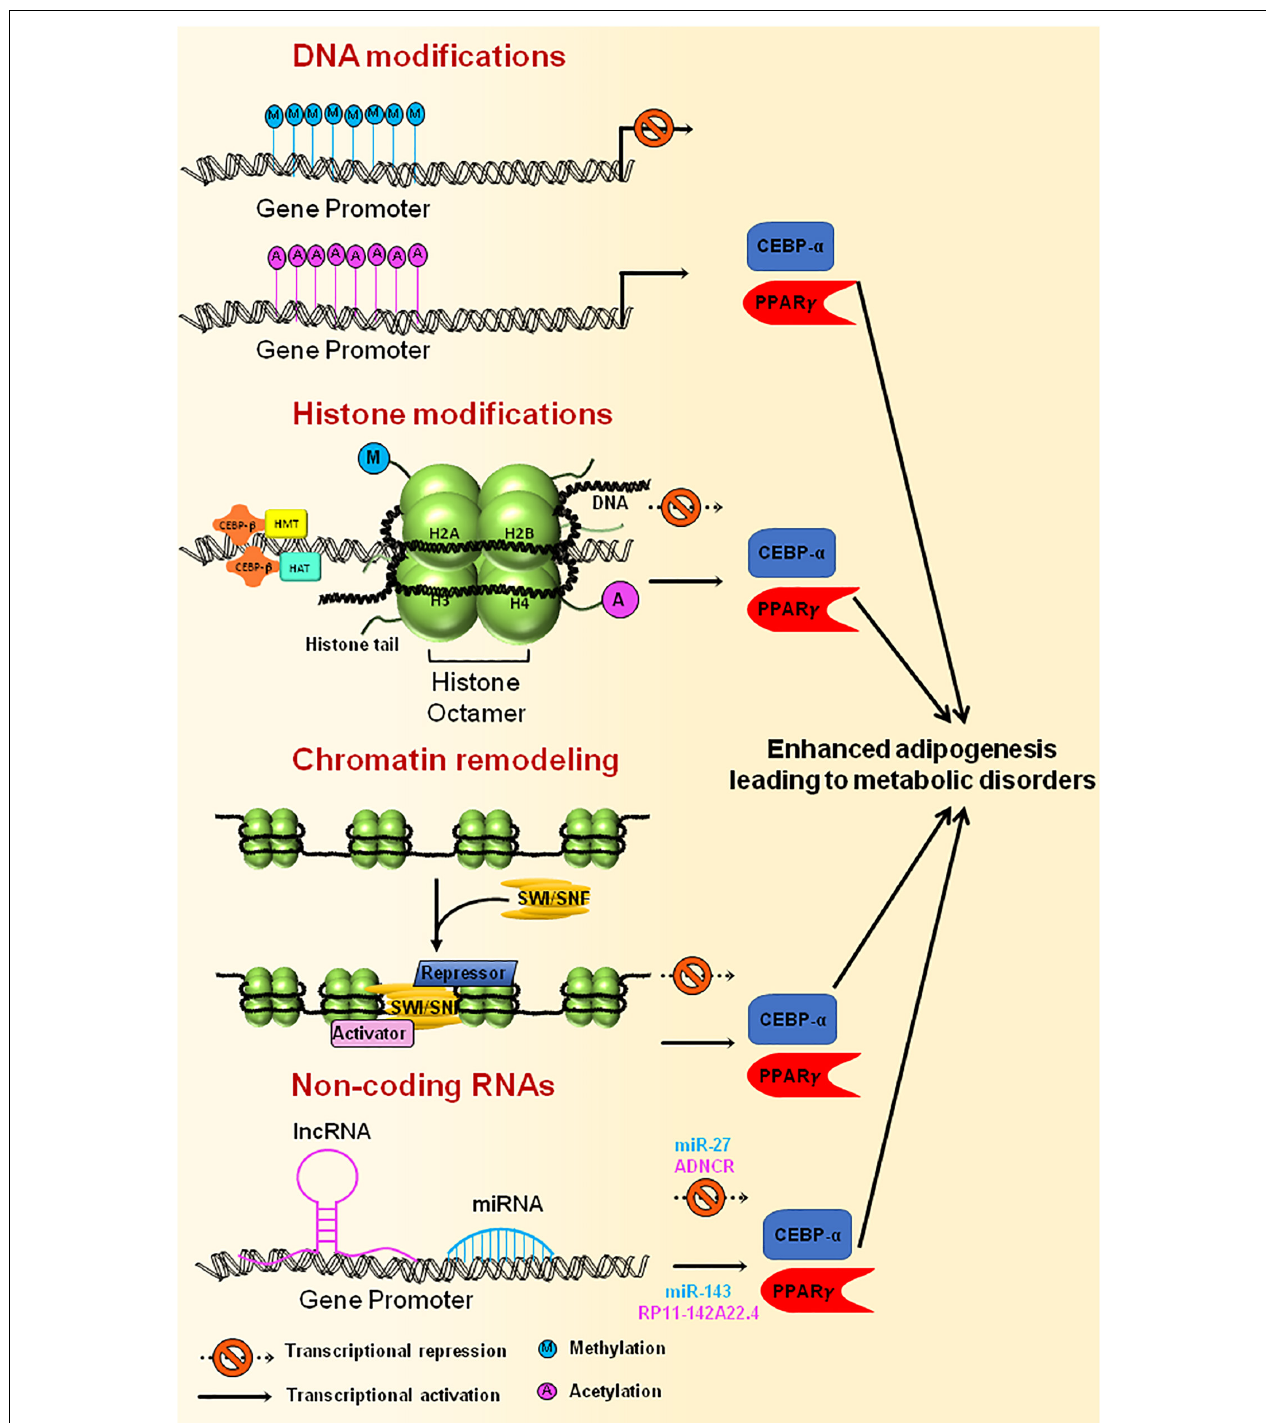
FIGURE 5 | Epigenetic modification of genes involved in adipogenesis. Methylation of gene promoters, that are necessary for adipogenesis, results in inactivation of the genes leading to reduced adipogenesis, whereas acetylation of promoter region brings about active adipocyte differentiation. Histone modification through HATs or HMTs that are recruited at the gene promoter by CEBP β results in either activation or repression of the genes that are essential for adipogenesis. Chromatin remodeling complexes, such as SWI/SNF, tends to change the chromatin structure, thereby making the DNA either accessible or inaccessible for the transcription of adipogenesis specific genes to happen. Non-coding RNAs also govern the transcription of master regulators of adipogenesis by activating (miR-143, RP11-142A22.4) or repressing (miR-27, ADNCR) the transcription of key genes required for adipogenesis. Uncontrolled expression of genes involved in adipogenesis could ultimately lead to metabolic